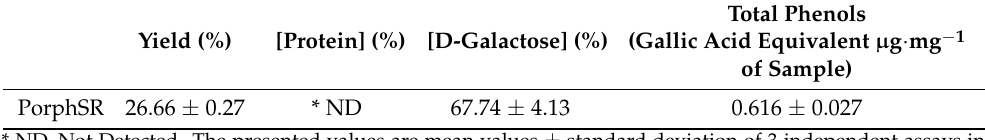
Table 2. Characterization of semi-refined porphyran extracts obtained by the method described.